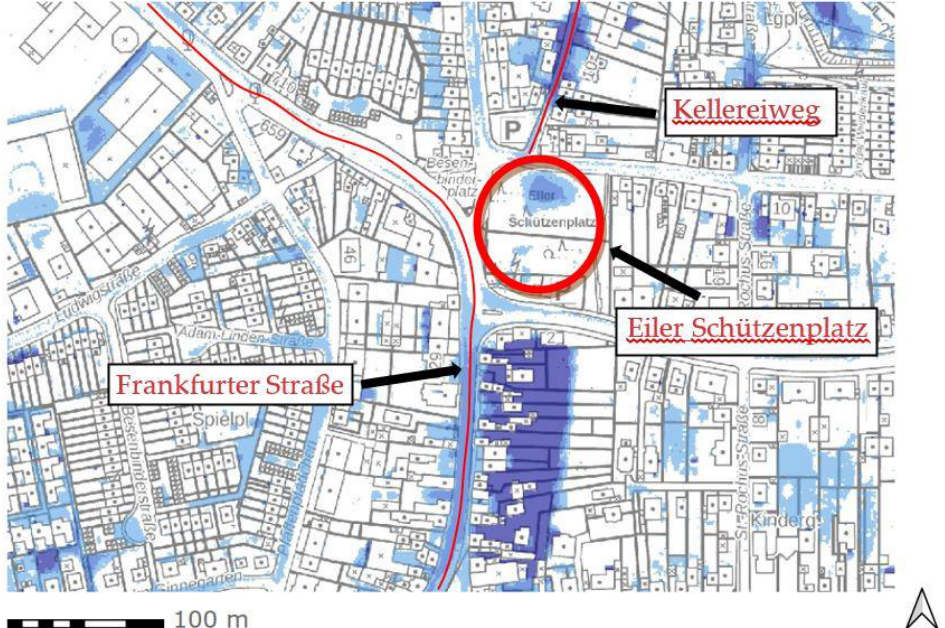
Figure 3. Hazard map for an extreme heavy precipitation event in the study area [33]. The darker the shade of blue, the higher the expected water depth and therefore the greater the risk of pluvial flooding. The red circle marks the site that will be transformed into a water plaza.